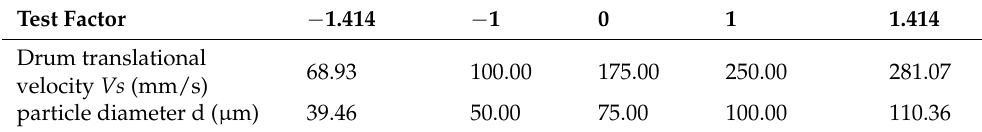
Table 3. Design factor level of DEM simulation test for nylon powder laying process.